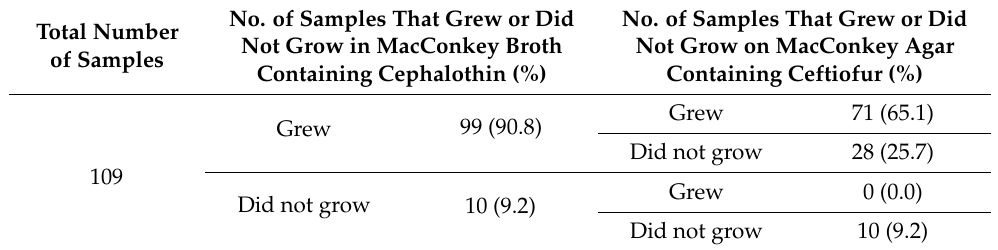
Table 3. Distribution of growth under each cephalosporin in samples isolated from dogs and cats.